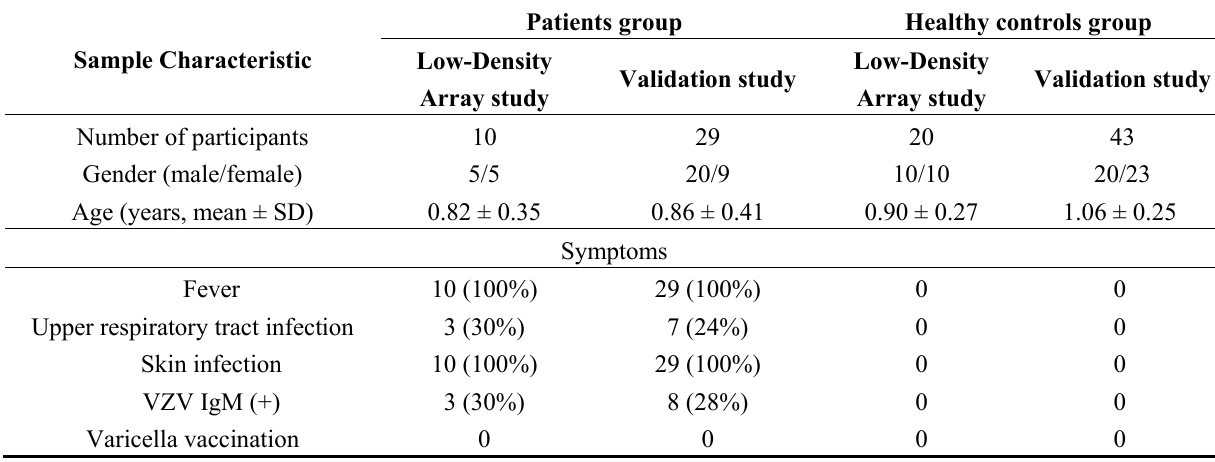
Table 1. Demographic characteristics of varicella patients and healthy